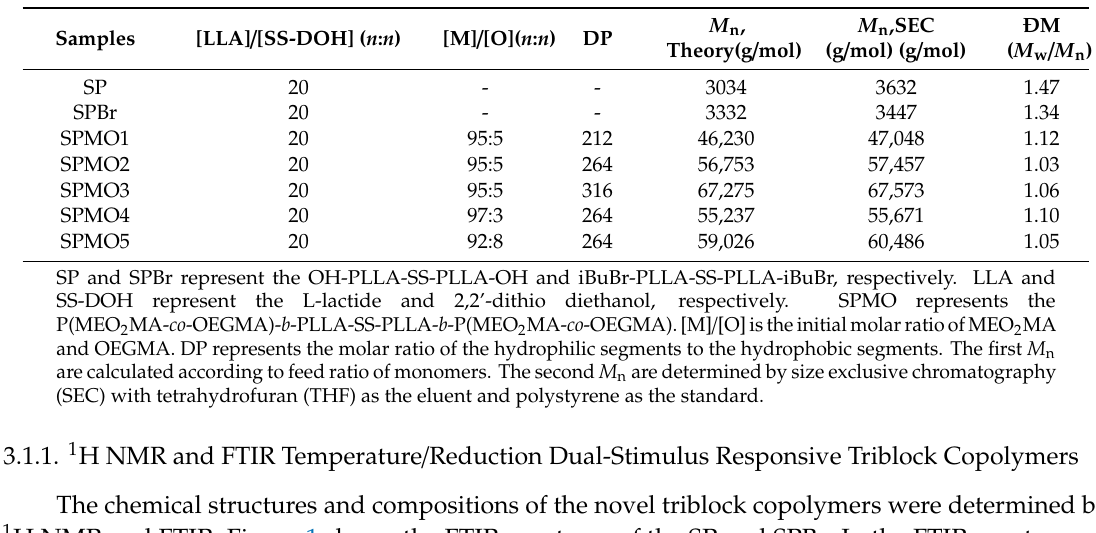
Table 1. Synthesis data of amphiphilic copolymers.